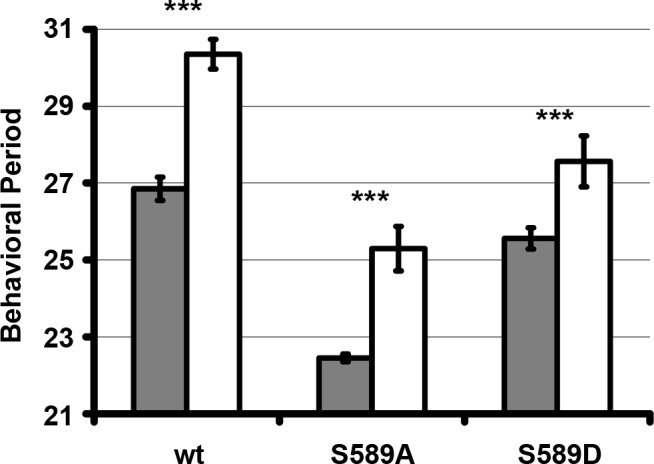
Residue substitutions of S589 do not genetically interact with O-Glc-NAc Transferase (OGT).The behavioral period of heterozygous flies carrying the transgenic per variant (as indicated) in the absence of DBT overexpression (grey bars, per0; [per] / +; +) or with DBT overexpression in clock neurons (white bars, per0; [per]/tim-UAS-Gal4, UAS-OGT; +) were quantified and plotted. N = 7–16. Bars represent means ±SD. ***p<0.001. Significance was measured by t-test. See Supplementary file 1 for values.